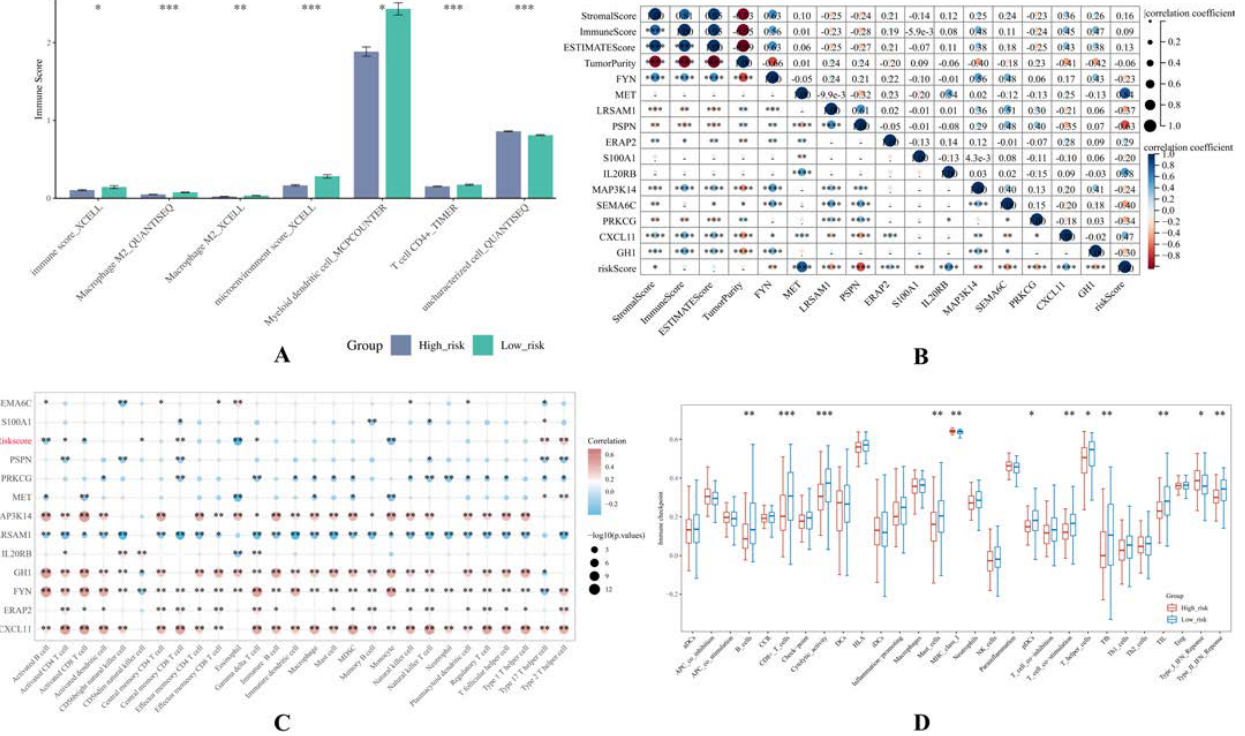
Figure 6. Correlation analysis between the risk score, IRGPI genes, and infiltrating immune cells. ( A ) The histogram demonstrates the 7 immune-related scores which are statistically different in the high- and low-risk groups. ( B ) The heatmap demonstrates the correlation between the risk score, IRGPI genes, immune score, stromal score, ESTIMATE score, and Tumor Purity value. The black circles represent the definite value of Spearman coefficients, and the color bar represents positivity or negativity. The deeper color in blue means the more negative the Spearman coefficient is. The deeper color in red means the more positive the Spearman coefficient is. ( C ) The bubble matrix demonstrates the summary of the correlation between the risk score, IRGPI genes, and 28 infiltrating immune cell types. ( D ) The box plot demonstrates the differences in immune cell infiltration in high- and low-risk groups.